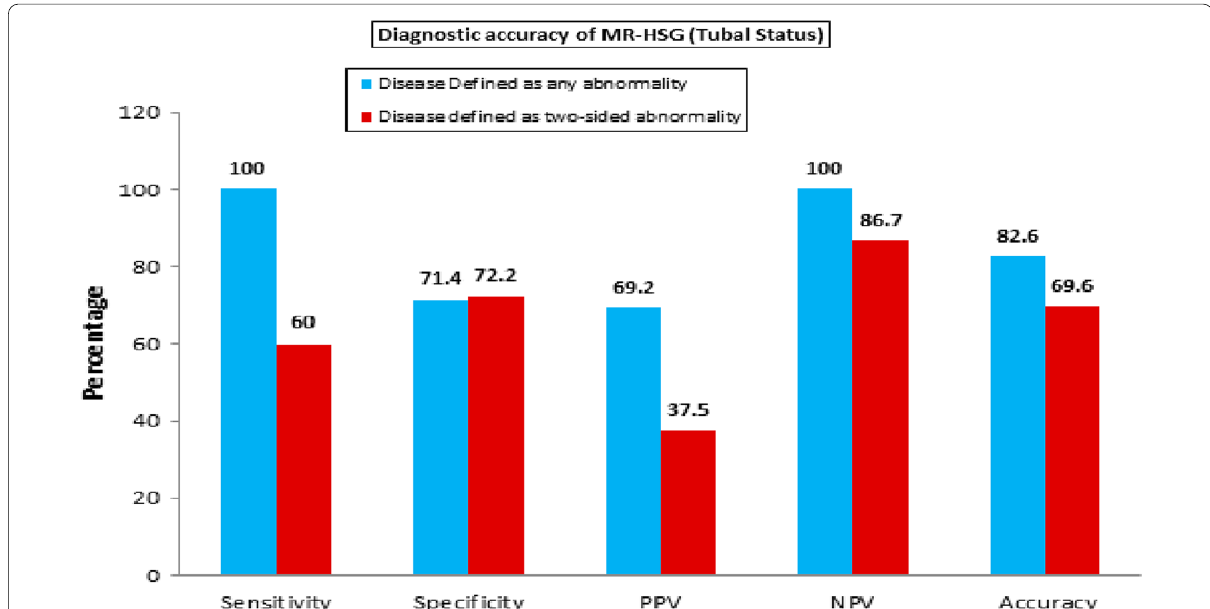
Fig. 1 Bar graph depicting the sensitivity, specificity, positive predictive value and negative predictive value of MR HSG for assessment of tubal